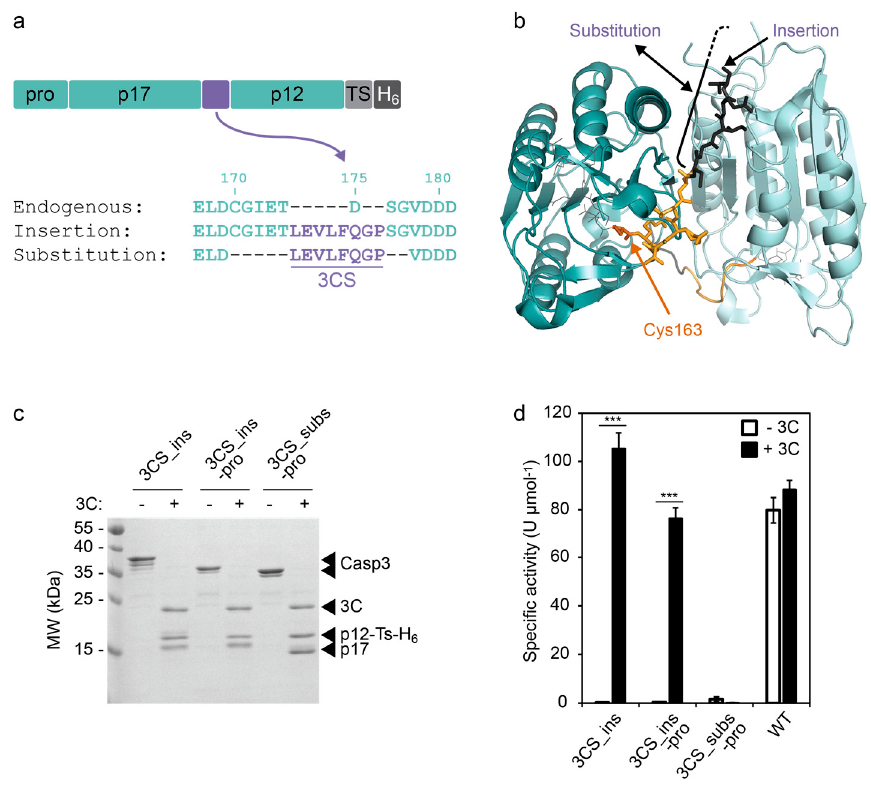
Figure 1. Design and testing of a 3C protease-inducible CASP3. ( a ) Incorporation of a 3C protease cleavage site (3CS) between the large (p17) and small (p12) subunits of CASP3. 3CS was inserted at position 175 (termed “insertion”), thereby deleting the endogenous aspartate for autoprocessing. Alternatively, residues 170–177 were substituted with 3CS (termed “substitution”). A hexa-histidine tag (H 6 ), which can optionally be removed via a TEV protease cleavage site (TS), was fused to the C-terminus of the caspases. ( b ) Structure of mature CASP3 (PDB ID: 3EDQ [22]). The two p12 / p17 heterodimers are colored in dark and light cyan, respectively. The site of 3CS insertion is indicated by a black arrow. The substituted amino acids 170–174 are colored in black (residues 175–177 are not included in the structure). The yellow and black colored residues constitute loop L2, which contains the catalytic cysteine-163 (marked in orange). The figure was generated using PyMOL [23]. ( c ) Cleavage of CASP3 constructs by 3C protease. The 0.2 mg / mL CASP3 constructs 3CS_ins (5.3 µ M), 3CS_ins-pro (5.7 µ M), and 3CS_subs-pro (5.8 µ M) were incubated in the absence ( − ) or presence ( + , 2.4 µ M) of 3C protease (3C) for 4 h at RT and analyzed using SDS-PAGE. ( d ) Activity of CASP3 constructs. The indicated constructs were incubated in the absence ( − 3C) or presence ( + 3C, 2.4 µ M) of the 3C protease in the same way as described in (c) (the WT concentration was 5.4 µ M). The specific activity of CASP3 in 1:100-diluted samples was determined by a colorimetric assay using a synthetic DEVD- p NA substrate. Mean values of three replicates +/ − s.e.m. are shown. Statistics: unpaired t-test; *** p < 0.005. Construct abbreviations: 3CS_ins, CASP3 with inserted 3CS; 3CS_ins-pro, 3CS_ins with deleted prodomain; 3CS_subs-pro, CASP3 with substituted cleavage site and deleted prodomain; WT, wild-type with endogenous aspartate-175.